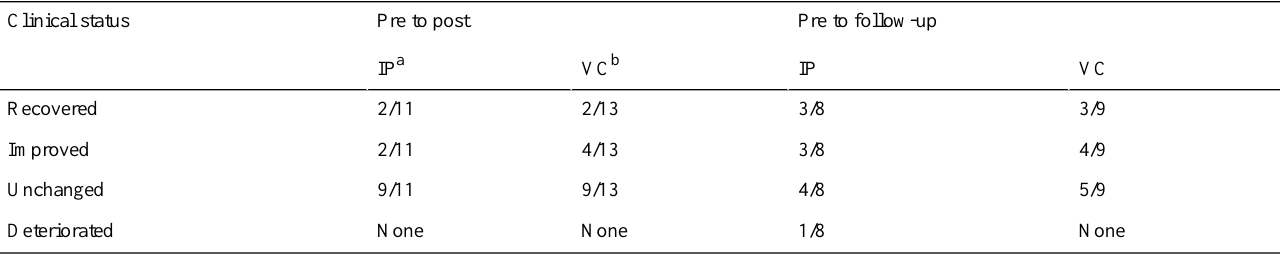
Table 6. Rates of clinical improvement from pre to posttreatment and follow-up for the QLES.